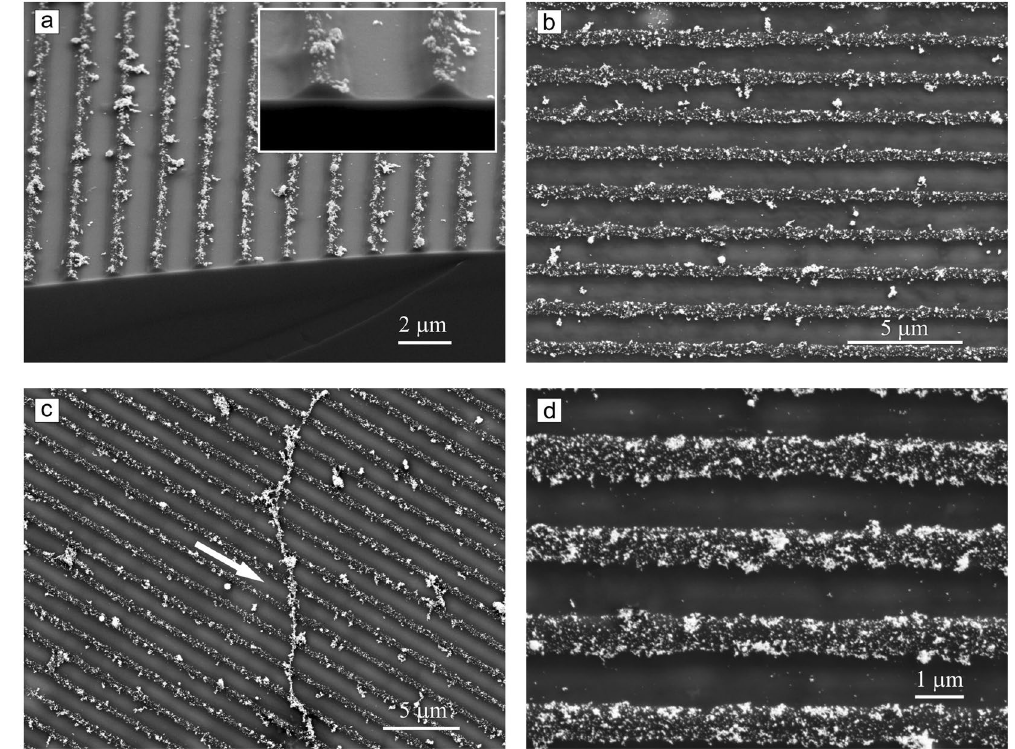
Figure 6. SEM micrographs of the polymer nano-wires filled with gold nano-particles. The gold nano-particles can be clearly identified within the nano-wires by their strong white contrasts. One nano-wire removed from its initial position during treatment with DMF is shown in c (marked by white arrow).